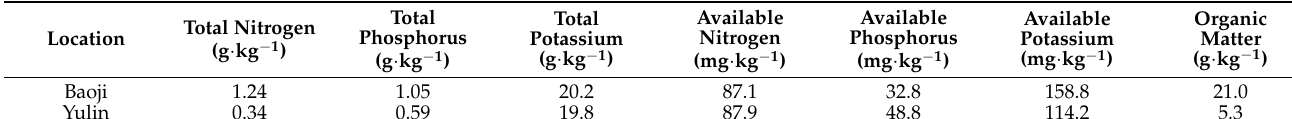
Table 1. The soil nutrient data before planting for the two sites.